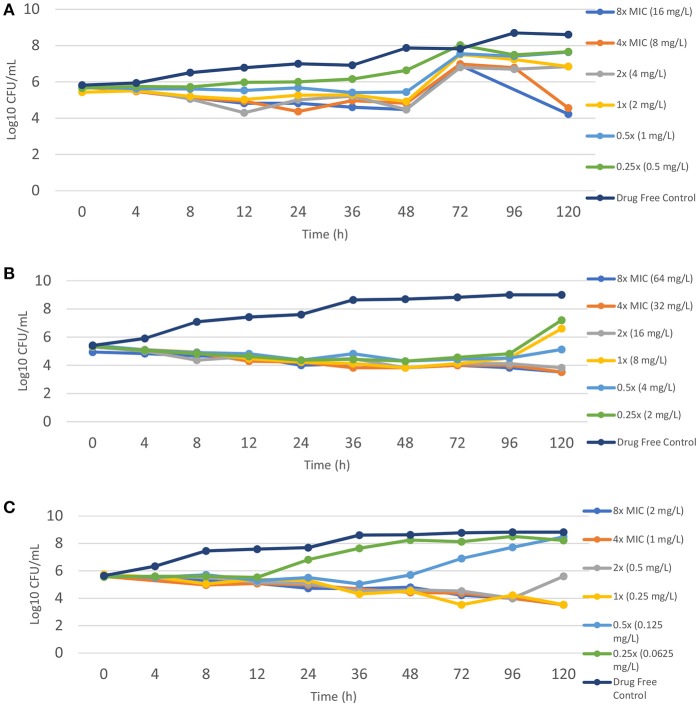
Time kill kinetics of tedizolid against different M. abscessus subspecies (A)
M. abscessus (TZD MIC = 2 mg/L); (B)
M. bolletii (TZD MIC = 8 mg/L); M. massiliense (TZD MIC = 0.5 mg/L). Each point represents the mean of duplicate determinations.